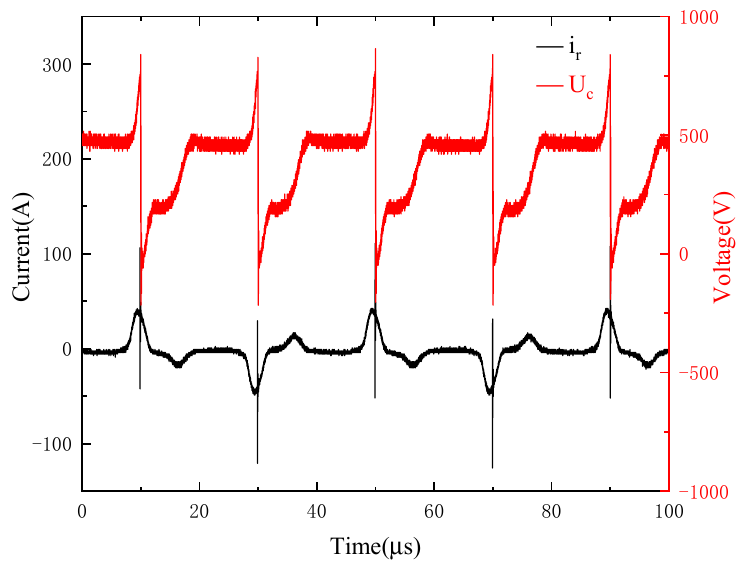
Figure 10. The voltage waveform of the load (circuit II): ( a ) discharge waveform with a repeatable frequency of 50 kHz; ( b ) enlarged view of load voltage in a different frequency.